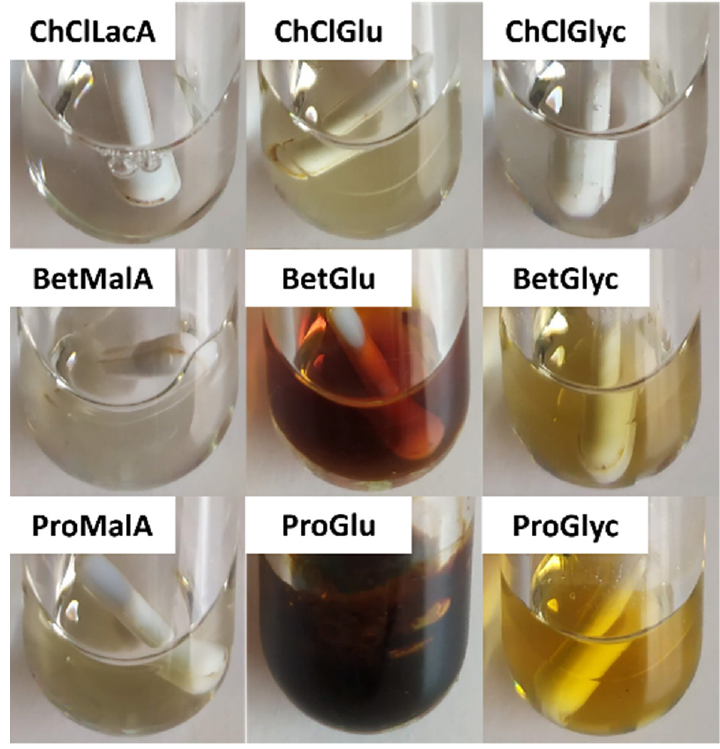
Figure 2. ESs after incubation in MAE at 130 °C for 10 min.